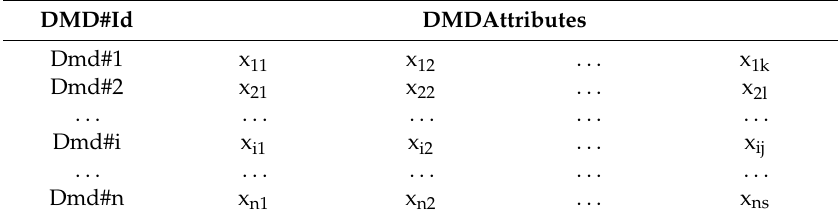
Table 2. Data Mashup Definition